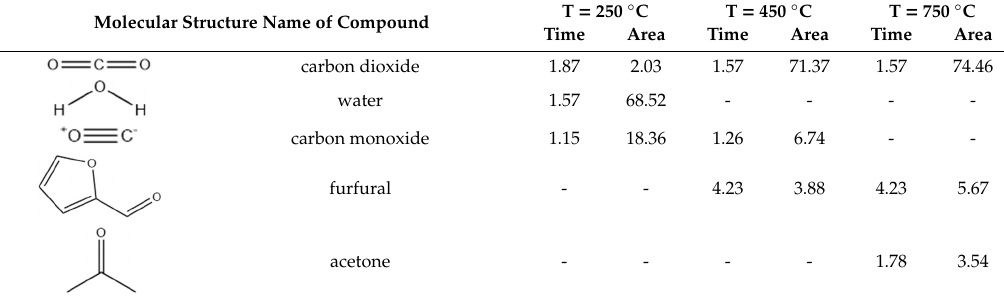
Figure 6. Py-GC-MS spectra of ZnAlg / Cu 2 O at 250 ◦ C ( a ), 450 ◦ C ( b ) and 750 ◦ C ( c ). Figure 6. Py-GC-MS spectra of ZnAlg/Cu 2 O at 250 ° C ( a ), 450 ° C ( b ) and 750 ° C ( c ). Figure 6. Py-GC-MS spectra of ZnAlg/Cu 2 O at 250 ° C ( a ), 450 ° C ( b ) and 750 ° C ( c ). Figure 6. Py-GC-MS spectra of ZnAlg/Cu 2 O at 250 ° C ( a ), 450 ° C ( b ) and 750 ° C ( c ). Figure 6. Py-GC-MS spectra of ZnAlg/Cu 2 O at 250 ° C ( a ), 450 ° C ( b ) and 750 ° C ( c ). Figure 6. Py-GC-MS spectra of ZnAlg/Cu 2 O at 250 ° C ( a ), 450 ° C ( b ) and 750 ° C ( c ). Figure 6. Py-GC-MS spectra of ZnAlg/Cu 2 O at 250 ° C ( a ), 450 ° C ( b ) and 750 ° C ( c ). Table 2. Pyrolysis products of ZnAlg / Cu 2 O at di ff erent temperatures. Table 2. Pyrolysis products of ZnAlg/Cu 2 O at different temperatures. Table 2. Pyrolysis products of ZnAlg/Cu 2 O at different temperatures. Table 2. Pyrolysis products of ZnAlg/Cu 2 O at different temperatures. Table 2. Pyrolysis products of ZnAlg/Cu 2 O at different temperatures. Table 2. Pyrolysis products of ZnAlg/Cu 2 O at different Table 2. Pyrolysis products of ZnAlg/Cu 2 O at different temperatures.